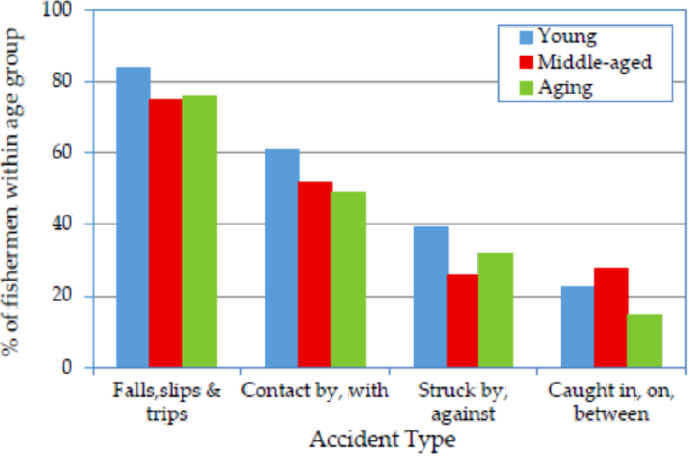
Figure 2. Prevalence of accident types reported by fishermen according to age group.